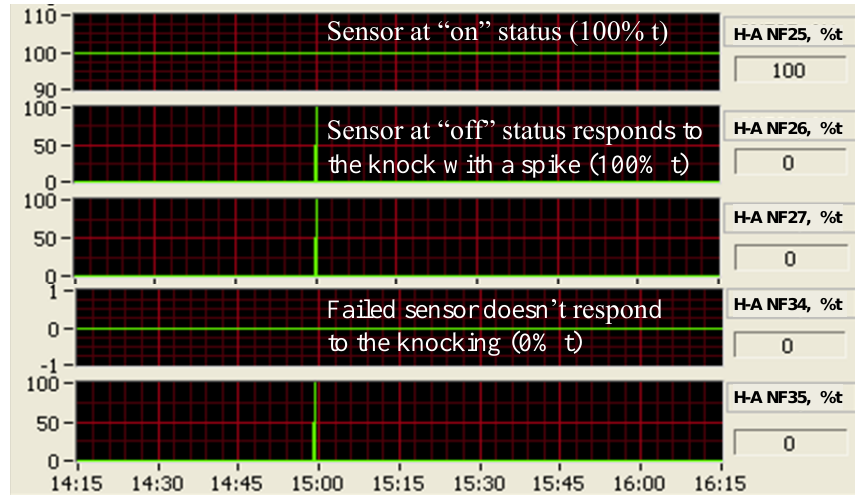
Figure 4. On-screen vibration sensor signals responding to fan cone knocking during sensor operational condition inspection.